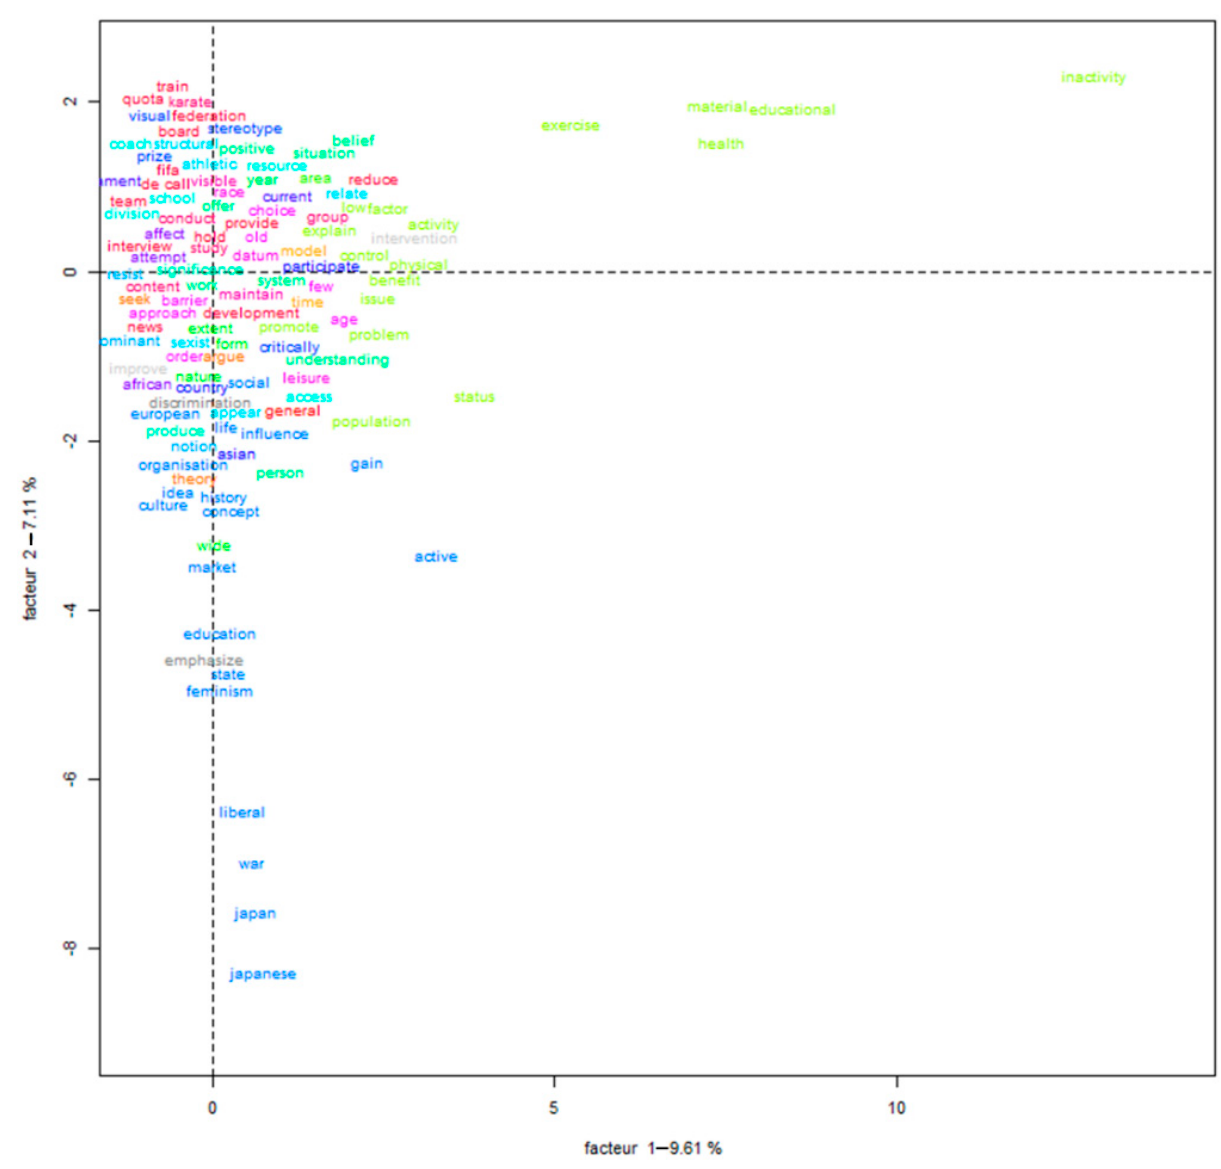
Figure 3. SRL of the inequalities in women’s sport using CFA.